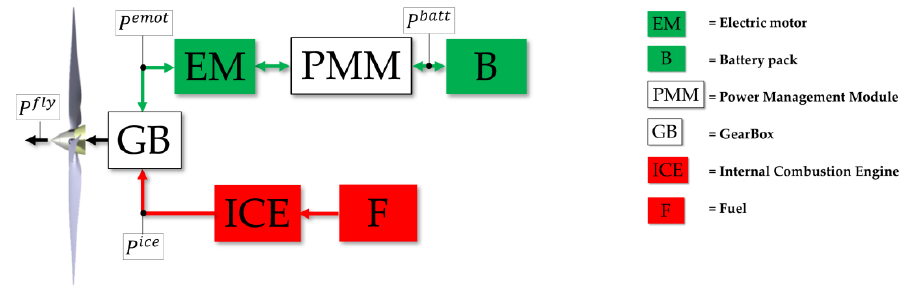
Figure 6. Scheme of the parallel hybrid-electric powertrain.